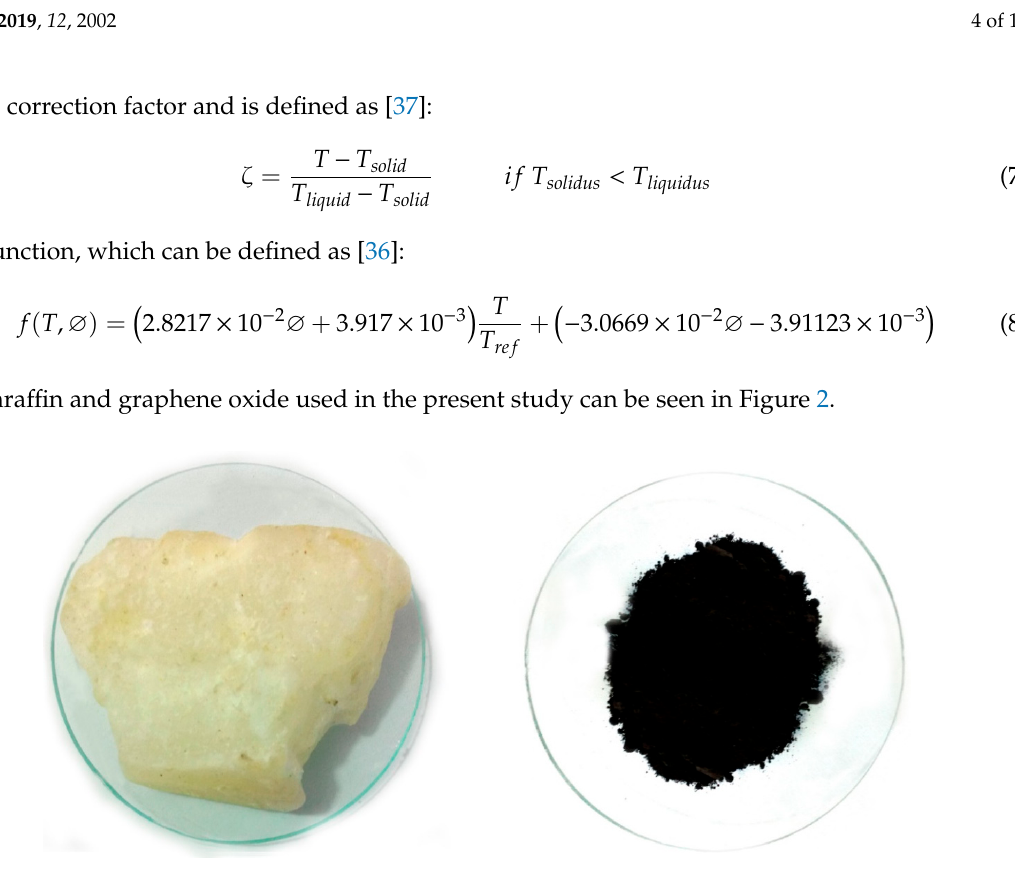
Figure 2. Materials used in the present study—( a ) paraffin and ( b ) graphene oxide.